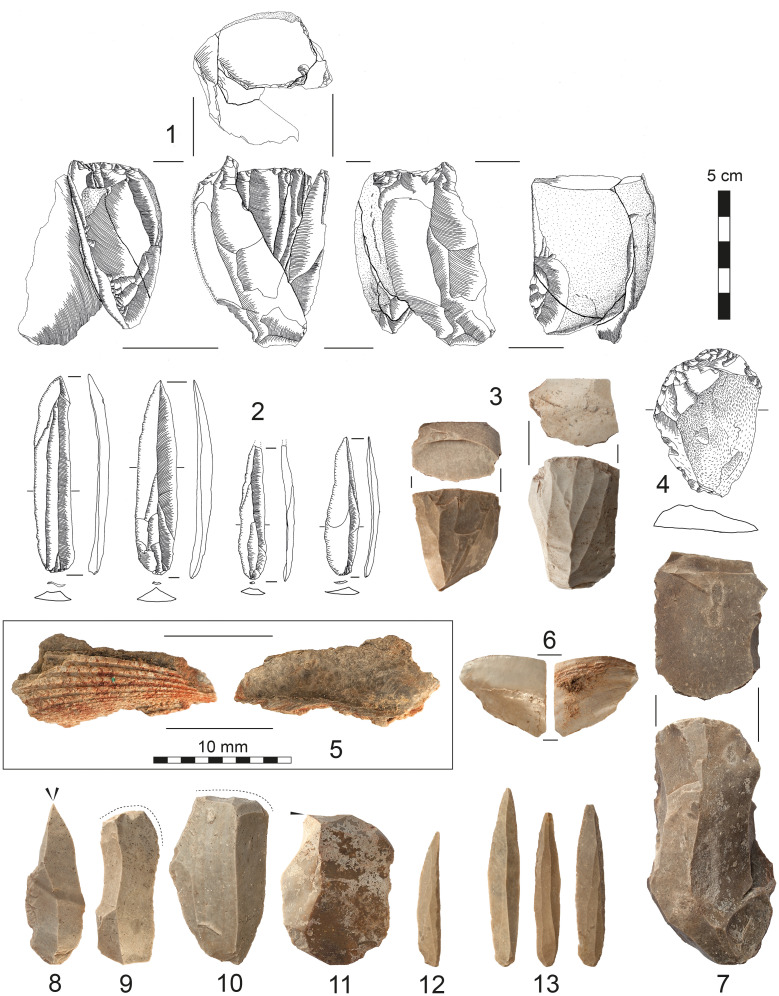
Artefacts from Al-Ansab 1.(1) Refitted blade core, (2) El-Wad points (3) blade cores, (4) end-scraper, (5) marine shell fragment with ochre staining, (6) marine shell fragment, (7) blade core (8) dihedral burin, (9, 10) end-scrapers, (11) burin and (12, 13) El-Wad points.